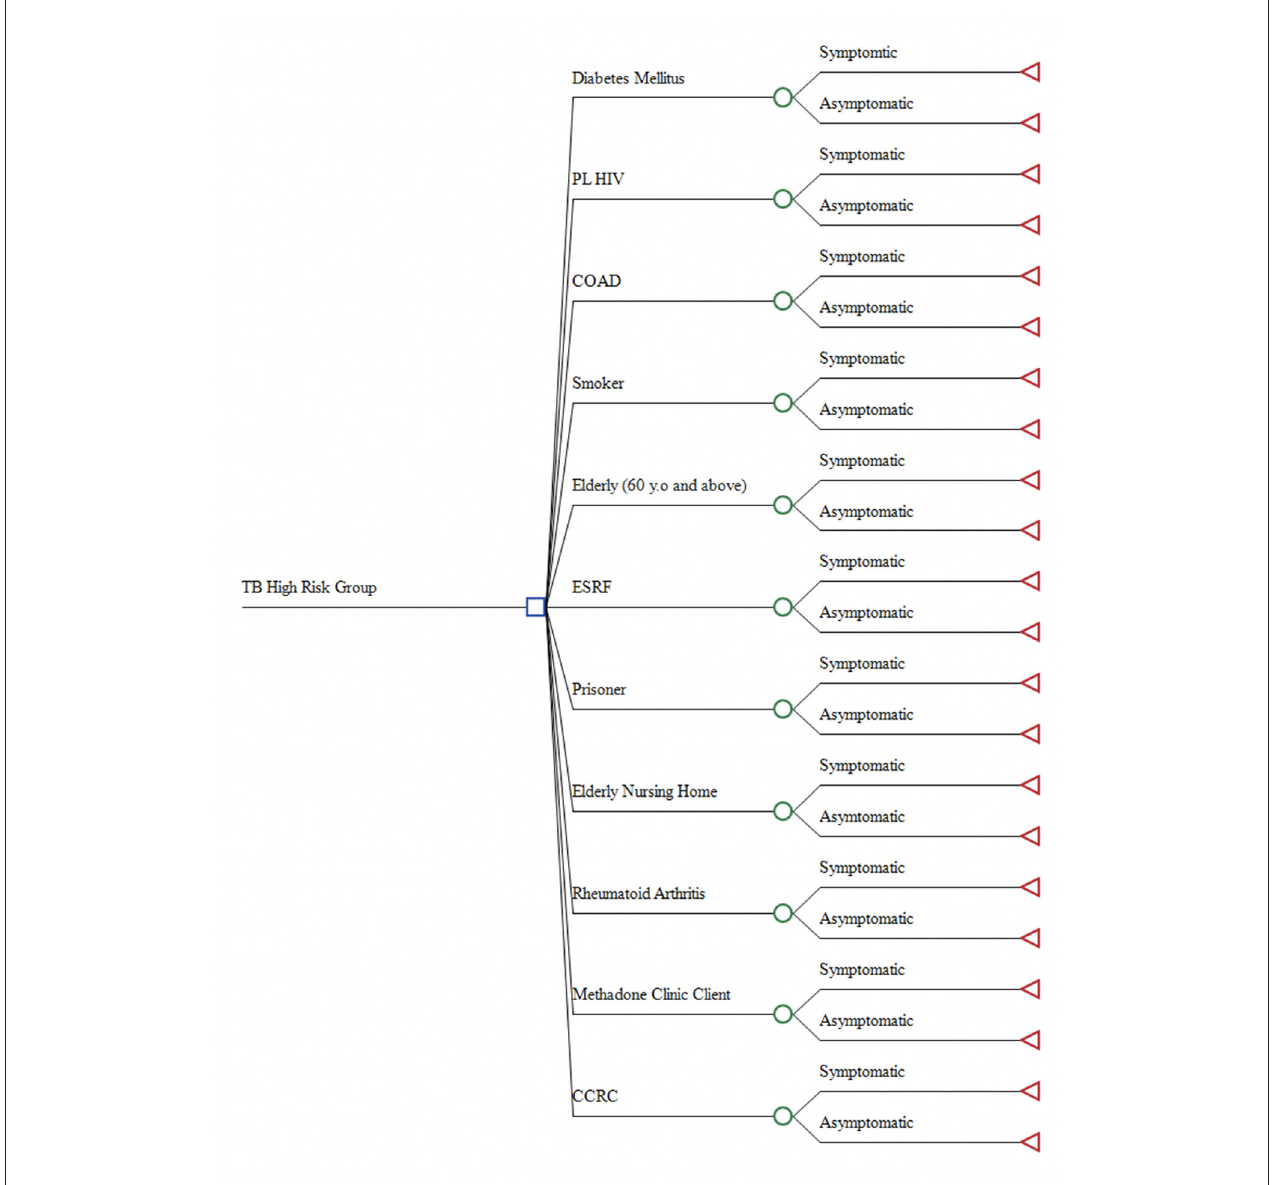
FIGURE 1 | Decision Tree